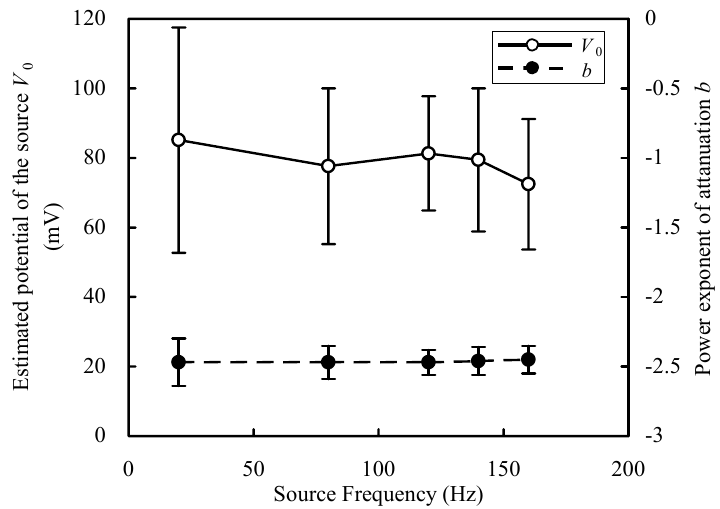
Fig. 5 Relationship between source frequency and regressed values (averages of the five experiments)